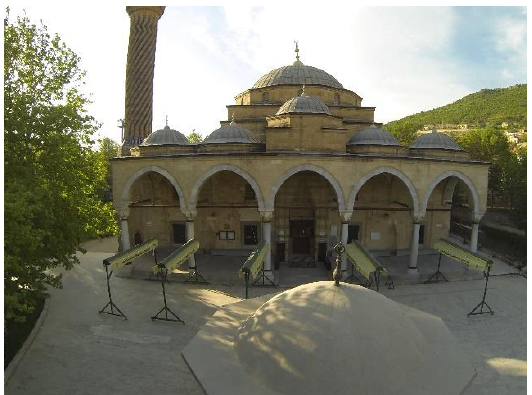
Figure 1. Gedik Ahmet Pasha Mosque